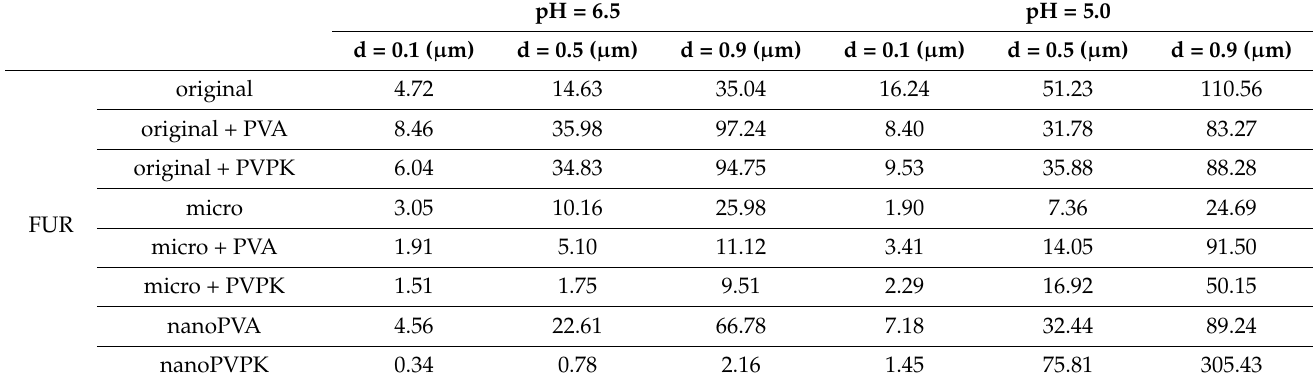
Table 4. Particle size distribution of the solid phase samples from the solubility measurements of furosemide.